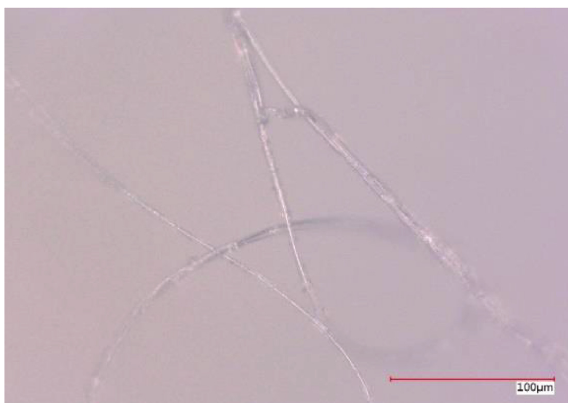
Figure 2: Image of fiber formed from 15% w/w PAN/DMF solution when spun at 3500 rpm and collecting rods at 17.78 cm away from the spinneret.